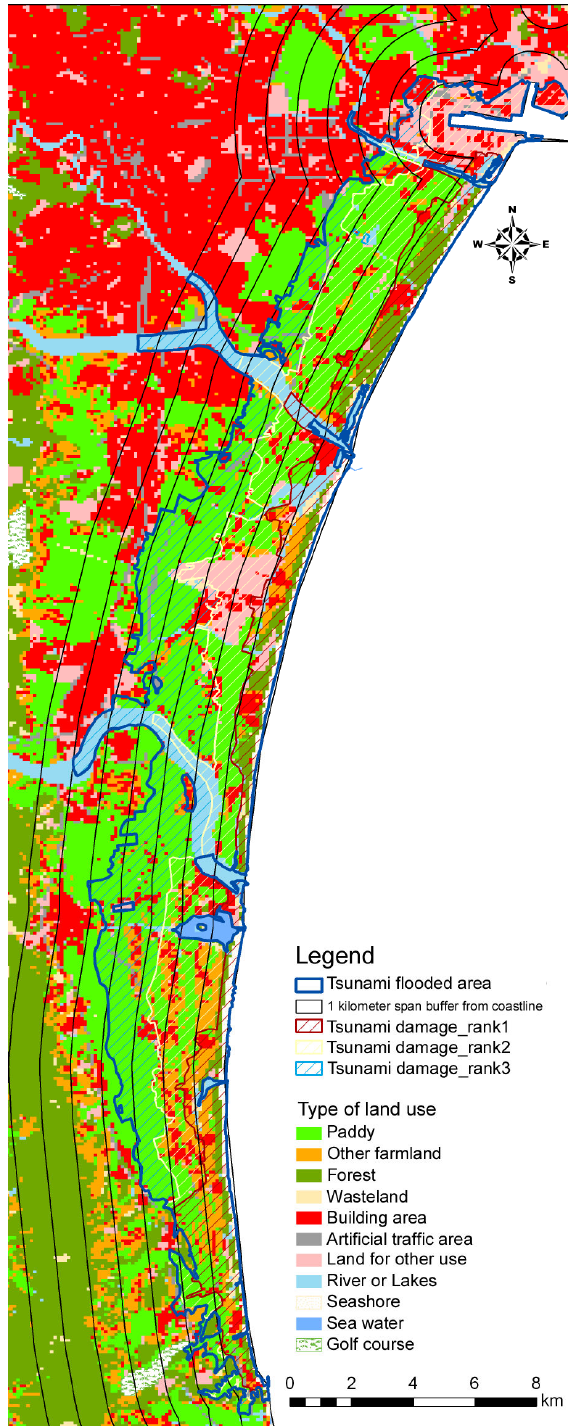
Figure 9. Overlay of tsunami damage and land use